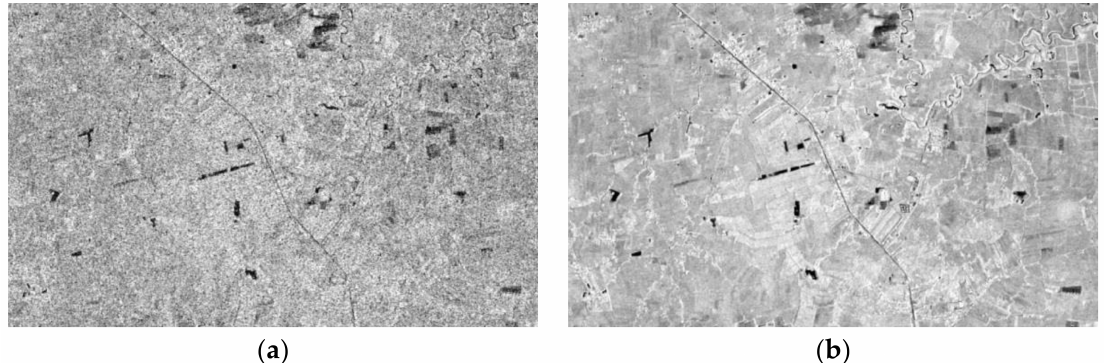
Figure 6. The σ 0 image of an ROI before ( a ) and after ( b ) multitemporal VH